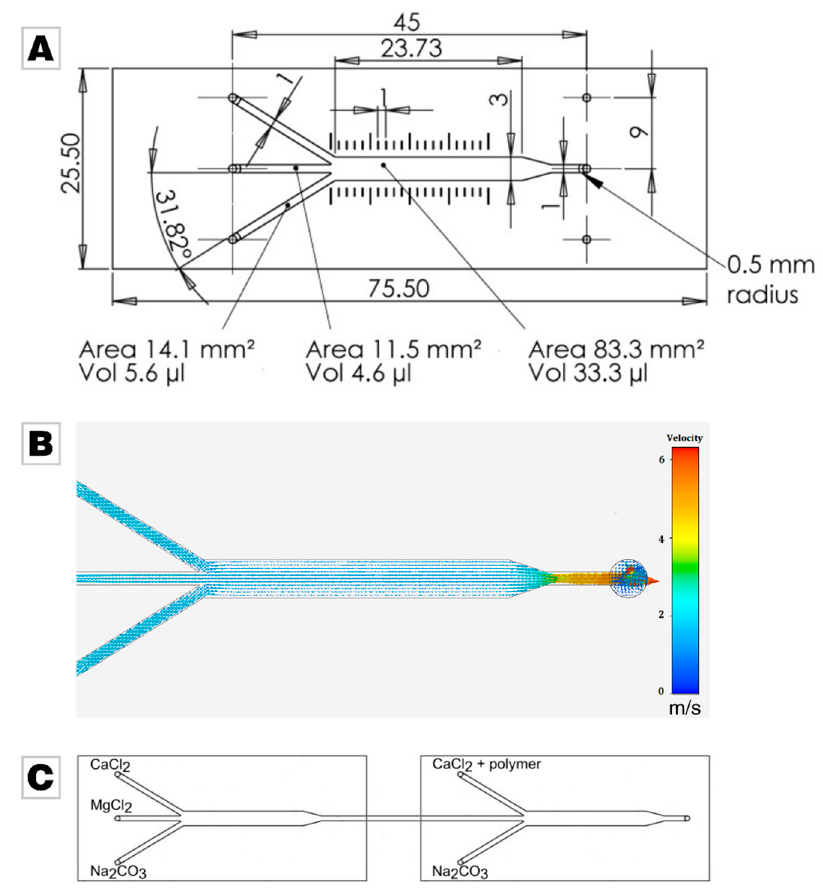
Figure 1. ( A ) Layout of the commercially available and employed microfluidic chip supplied by ibidi (Martinsried, Germany). Image used by courtesy of ibidi GmbH [53]. ( B ) Simulation of the fluid dynamics in the microfluidic chip at a feeding flow of 30 mL / min. Images used courtesy of ANSYS, Inc. (Canonsburg, PA, USA) ( C ) Scheme of the experimental setup. In control experiments, only the calcium chloride solution was fed into the system in the second microfluidic chip, thus omitting the addition of polymer.